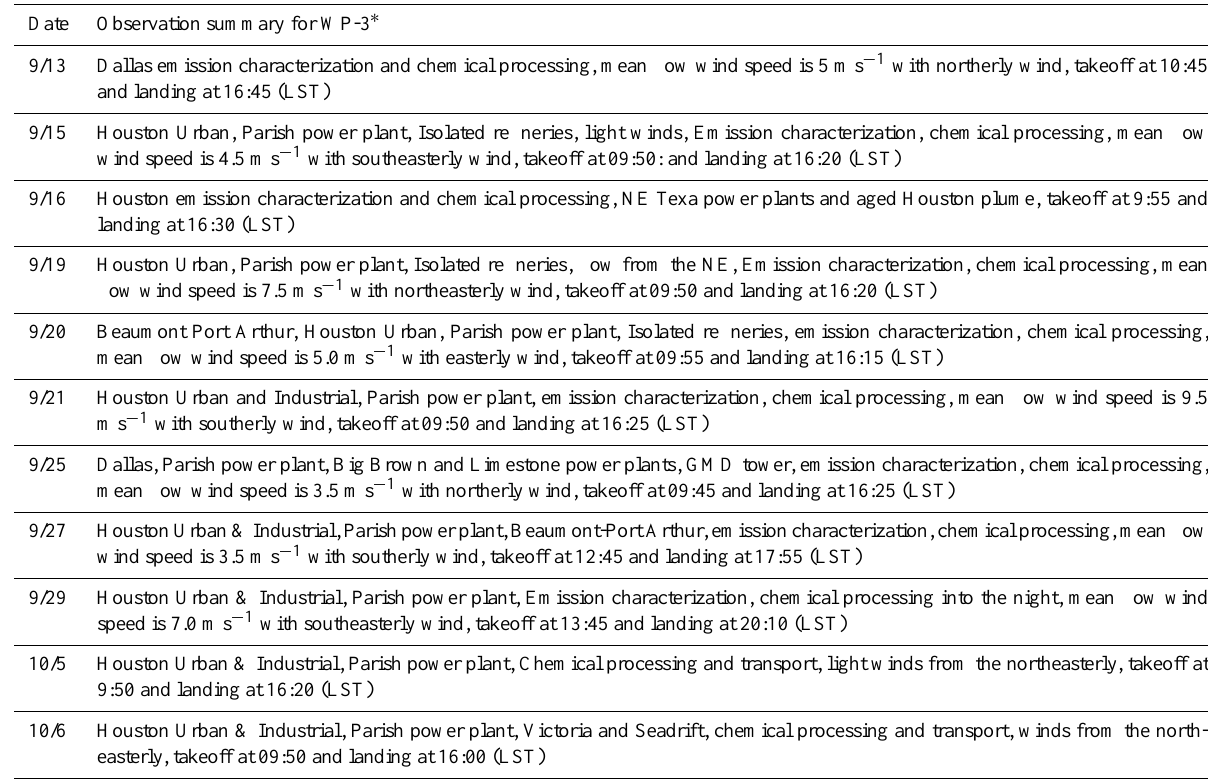
Table 3. Flight Observation Summary for WP-3 aircraft for PM during the 2006 TexAQS/GoMACCS